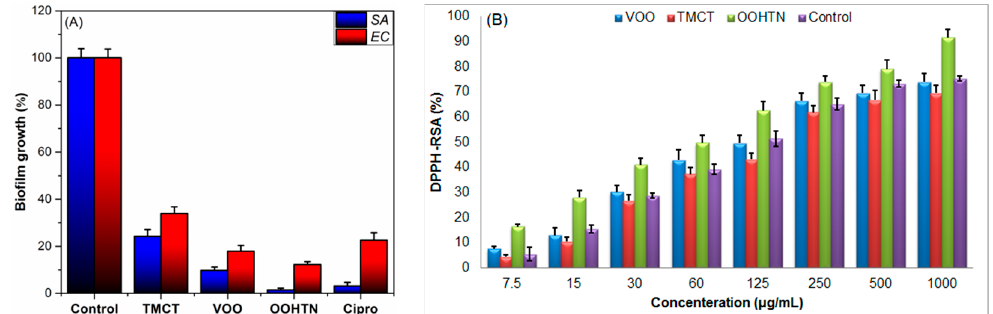
Figure 7. ( A ) Anti-biofilm activity graph for VOO-nanoformulations and their native ingredients against SA and EC , as compared to Cipro and DIW as a positive and negative control, respectively. ( B ) DPPH-RSA (%) for the same samples, ascorbic acid was used as a control.